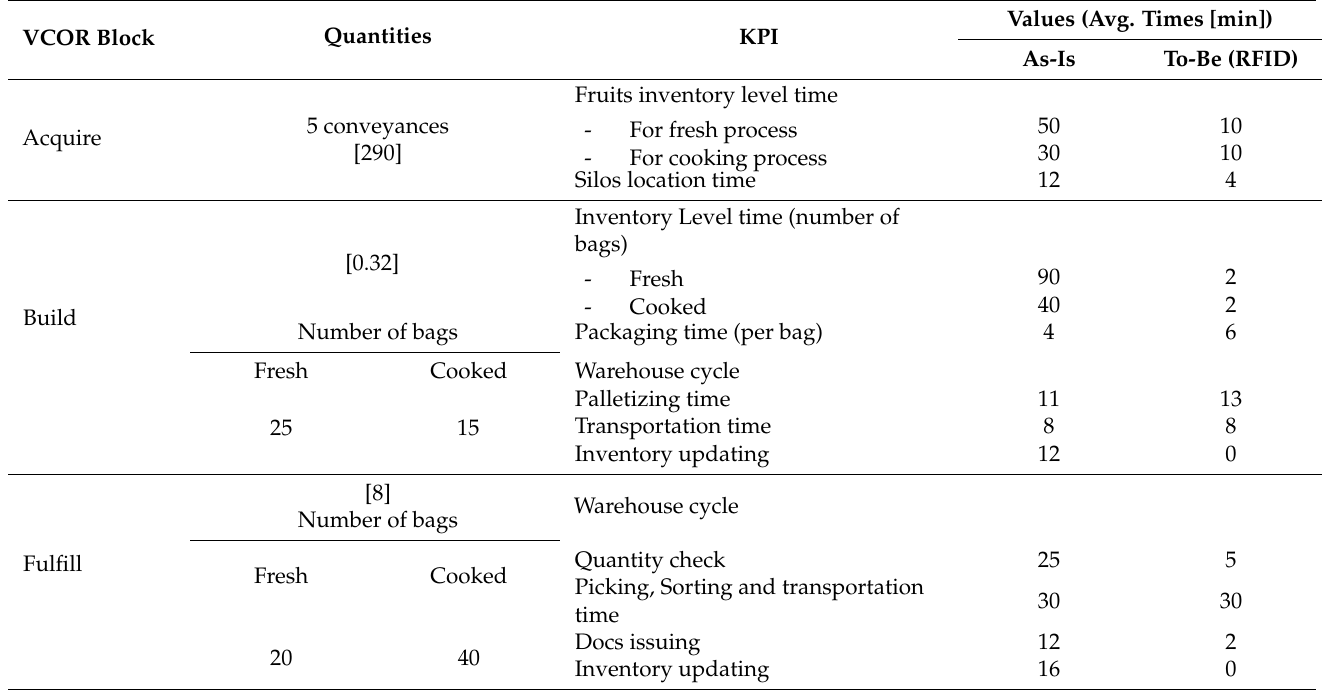
Table 10. KPI of the SC